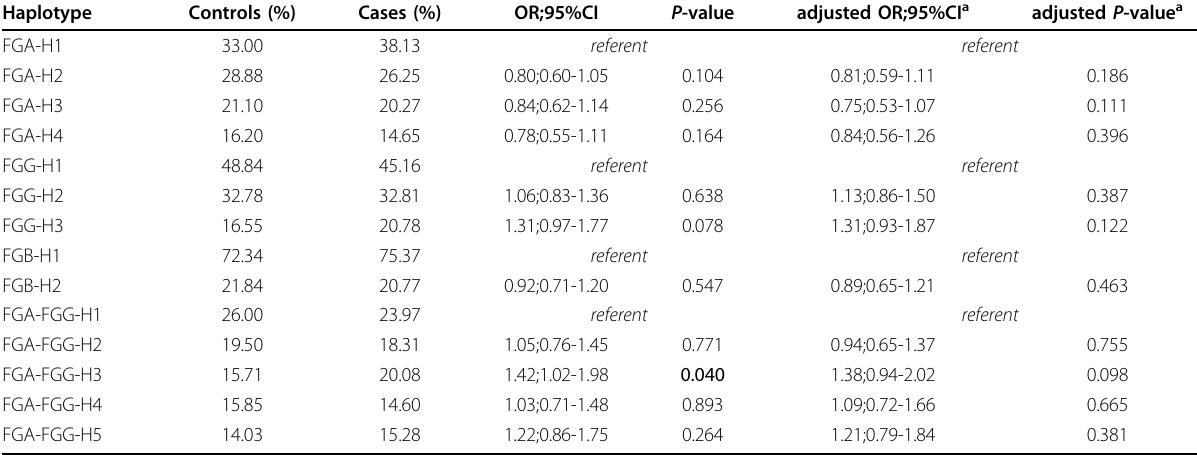
Bold and underlined letters indicate SNP minor alleles. Table 5 Frequencies, ORs and 95% CIs for CAD in relation to the most frequent haplotypes.